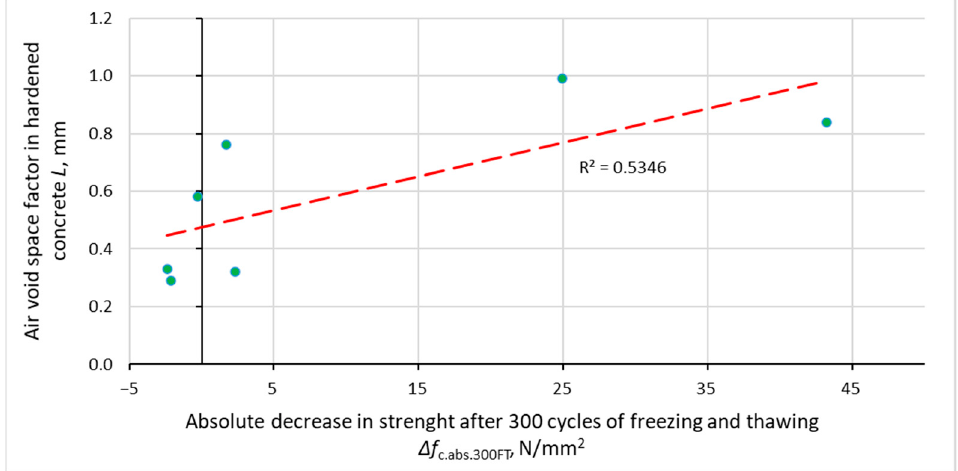
Figure 10. Relationship between air voids space factor in hardened concrete and reduction in concrete compressive strength after 300 cycles of freezing and thawing.